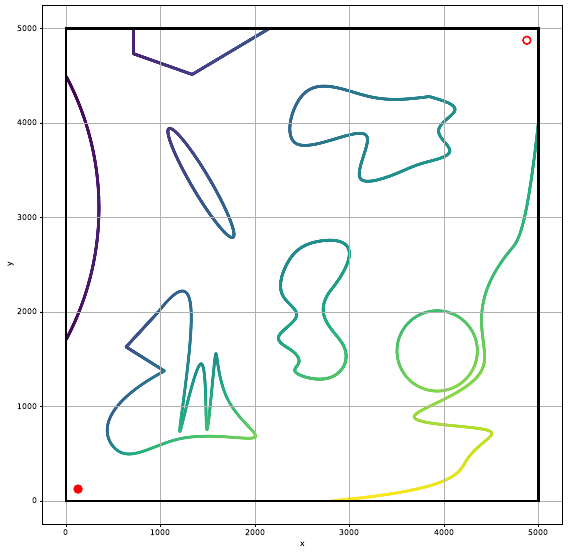
Figure 2. Initial global